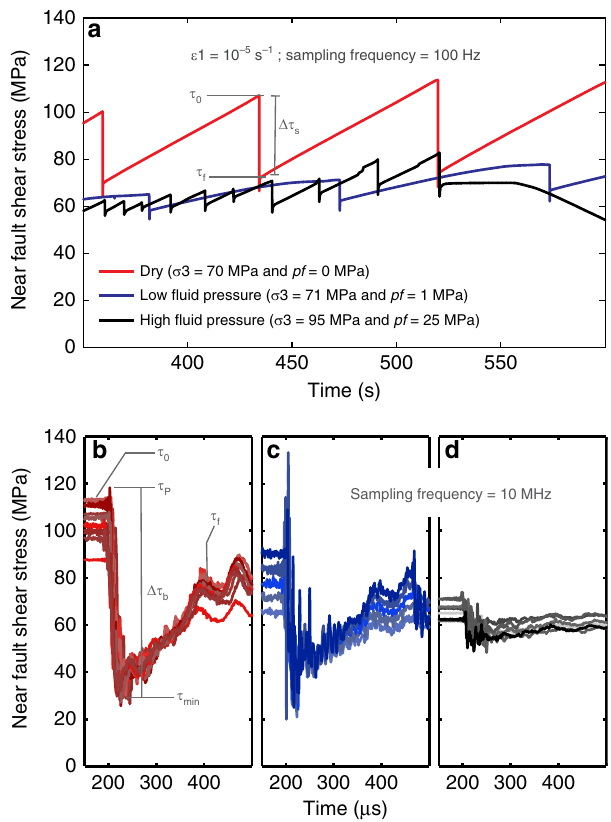
Fig. 1 Mechanical results for experiments at σ 3 ’ = 70 MPa. a Near-fault shear stress evolution with time. Static stress drop ( Δ τ s = τ 0 − τ f ) is shown as an example. b – d Dynamic shear stress evolution with time. Each curve corresponds to one stick-slip event, change in colour hue accounts for different events. In addition to τ 0 and τ f , the maximum and minimum dynamic values of shear stress, τ p and τ min , are presented as examples, de fi ning a breakdown stress drop ( Δ τ b = τ p − τ min ). b Dry experiment, red curves. c Low fl uid pressure experiment, blue curves. d High fl uid pressure experiment, black/grey